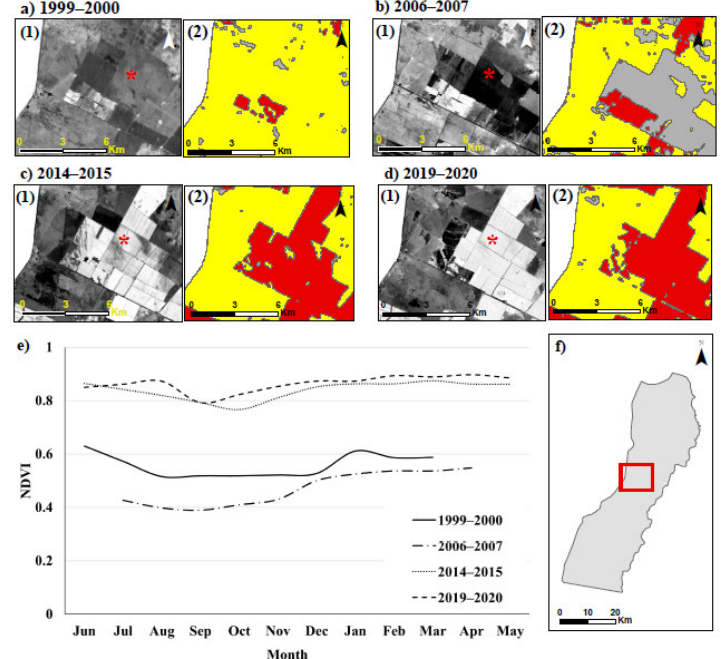
Figure 4. Example of transition between grassland–other covers–tree plantation from 1999 to 2020 in an area located at the central region of the Aguapey VGA ( a – d ), using as base maps (1) NDVI images from November (the only month included in all annual periods) and (2) unsupervised classification images with yellow showing grassland, grey other covers, and red tree plantation; ( e ) phenological signatures of a particular region of interest (*) for each annual period studied; missing values within the phenological cycle were estimated as the average between the predecessor and the following values; ( f ) Aguapey VGA study area.